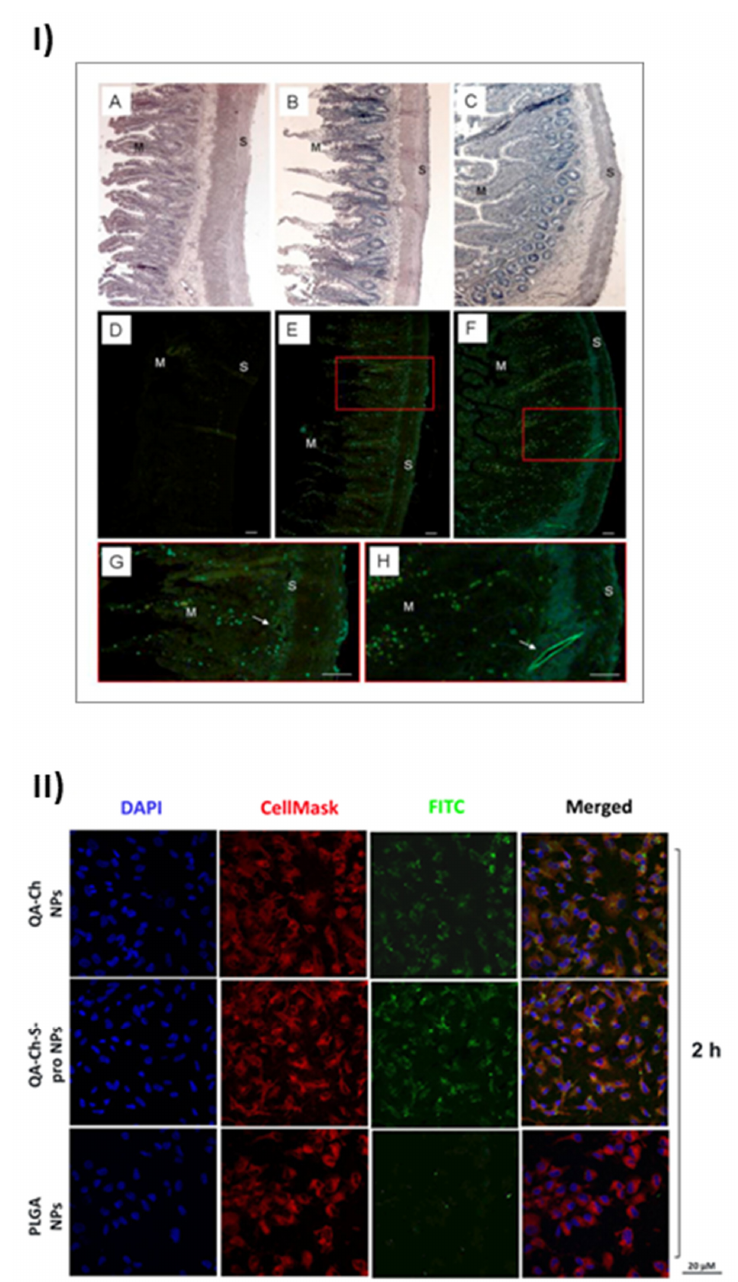
Figure 2. Results of the positive e ff ects of QA-Ch and its derivatives, taken from [61] and [63]. ( I ) Microphotographs of slices of rat intestinal wall observed under a light ( A – C ) or fluorescence ( D – H ) microscope following 1h incubation in an Ussing chamber with sodium fluorescein (NaFlu) solution ( A , D ); FITC-QA-Ch-based NP ( B , E , G ) or FITC-QA-Ch-SH-based NP ( C , F , H ). Haematoxylin-eosin stained sections ( A , B ) show intact intestinal epithelium. In the control sample (D) no florescence is visible, while some fluorescent spots are present in FITC-NP treated samples ( E – H ). The fluorescent spots are visible all across the gut section, from mucosal (M) to serosal (S) layer and at the level of vessels (arrows) ( G , H ). G and H are a larger magnification of boxes in E and F , respectively. Scale bar 50 µ m. ( II ) Confocal fluorescence microscopy analysis of human umbilical vein endothelial cells (HUVEC) incubated with FITC-labeled QA-Ch, QA-Ch-S-pro or PLGA NP (green color) for 2 h. CellMask and DAPI for staining the cellular membrane and nucleus are shown in red and blue colors, respectively. Scale bars are 20 µ m. Control is represented by untreated